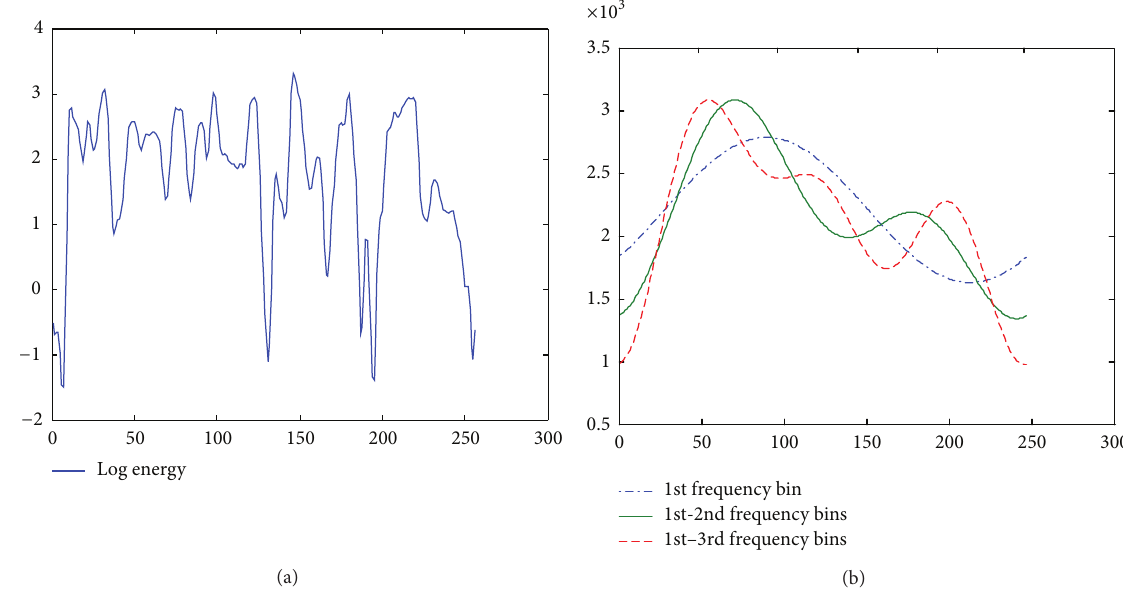
Figure 3: Examples of approximated LFE contours from an angry speech utterance.